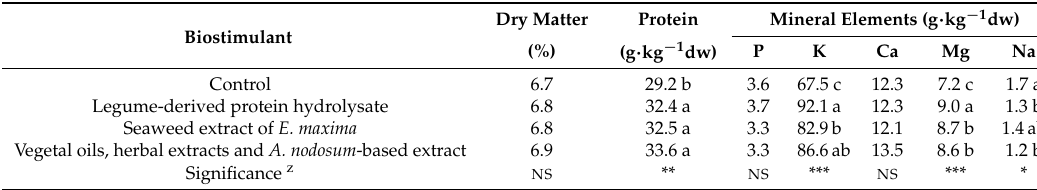
Table 3. The effect of biostimulant treatments on dry matter percentage, protein content, and mineral concentration of leaves in greenhouse spinach plants.